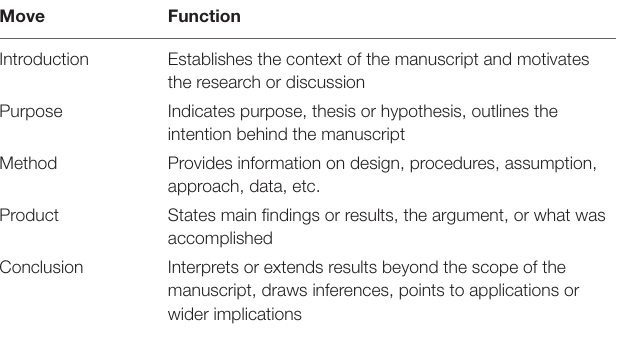
TABLE 1 | Hyland’s (2000) move model.